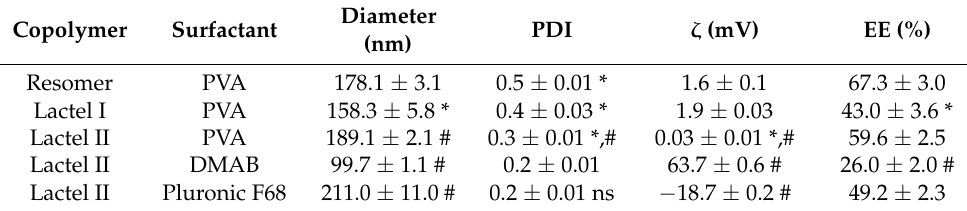
Table 1. Role of copolymers and surfactants in nanoparticle (NP)